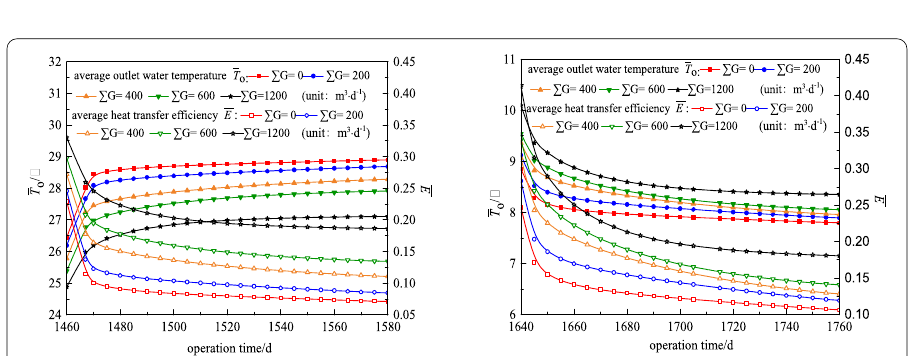
Fig. 12 Dynamic change of the average outlet water temperature ( ¯ T o ) and the average heat